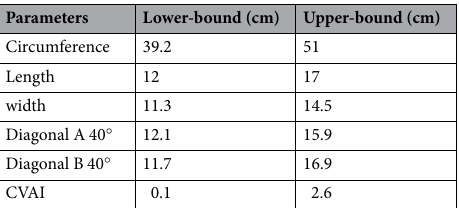
Table 1. Range of the recorded parameters of the studied patients collected by anthropometric caliper